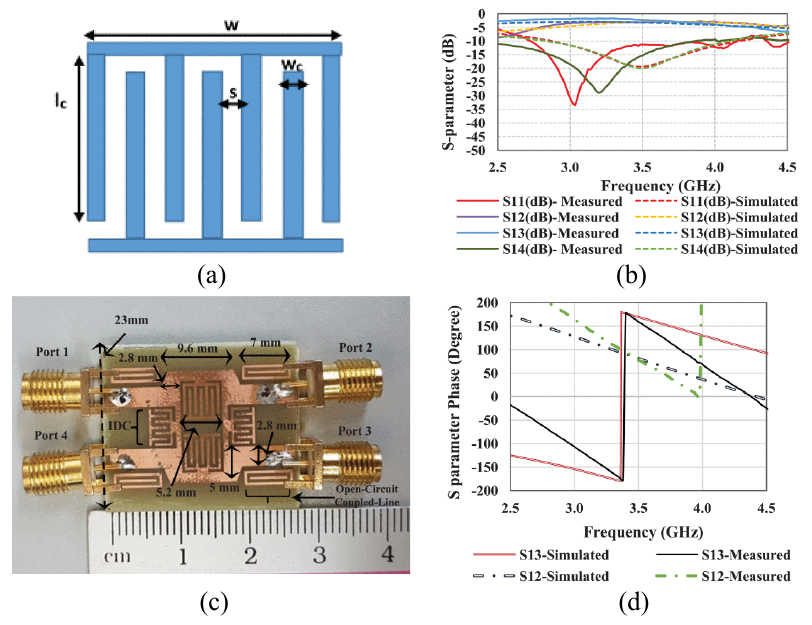
Figure 4. Schematics of the antenna in [27] with metamaterial to improve bandwidth. ( a ) Metamaterial structure, ( b ) S-parameters of the antenna, ( c ) fabricated prototype, ( d ) S-parameter phase. Reprinted from Ref. [27].